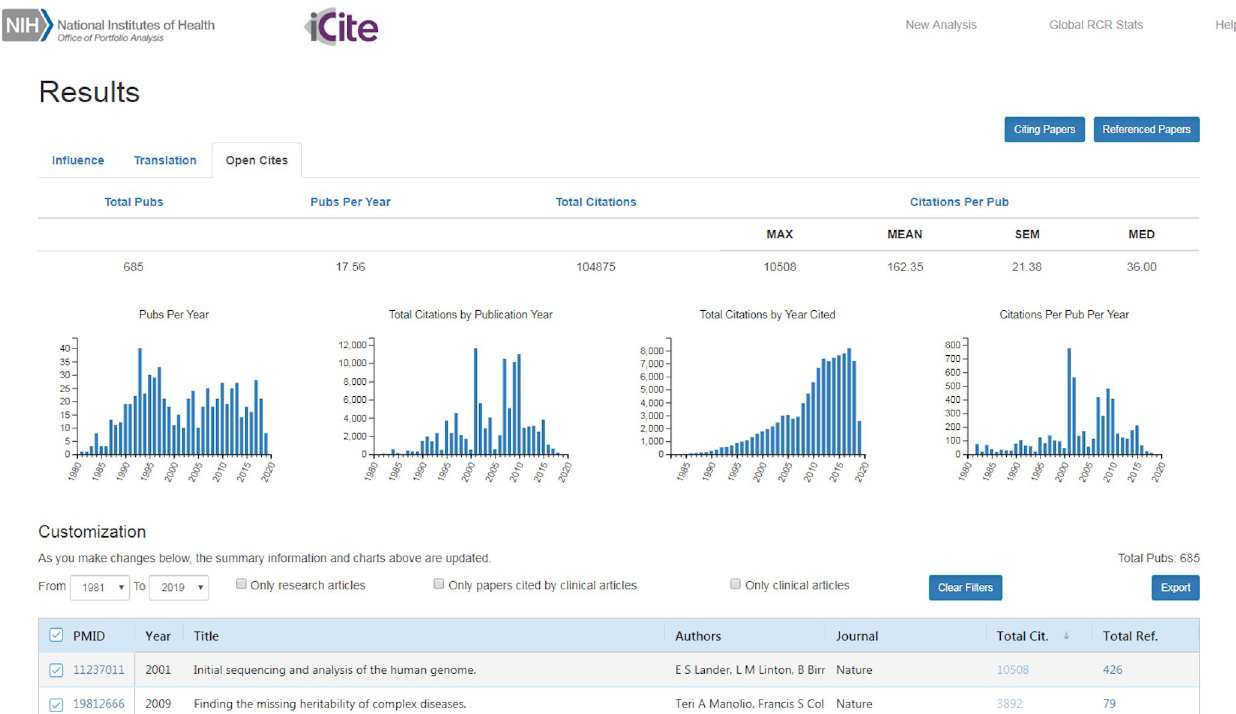
Fig 2. Screen capture of the iCite web interface to open citation data. The Open Citations module of iCite displays portfolio-level data in a summary table (top) and charts beneath the table. Charts provide visualization of publications over time (left), total citations per year by the publication year of the referenced article (center left), total citations per year by the publication year of the citing article (center right), and average citations per article in each publication year (right). Article-level information is shown on bottom and includes links to the PubMed records of the citing and referenced papers.